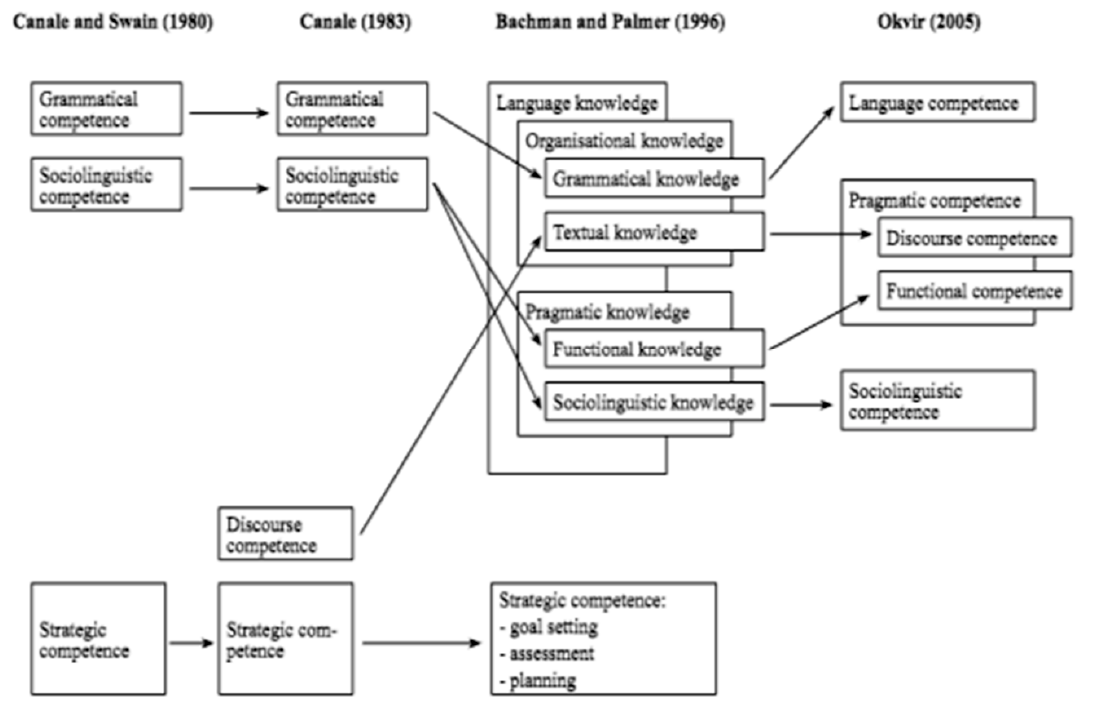
Figure 1. Similarities and differences between several models of communicative competence. Sources: Bagari ć and Djigunovi ć (2007: 102), Borger (2014: 27).